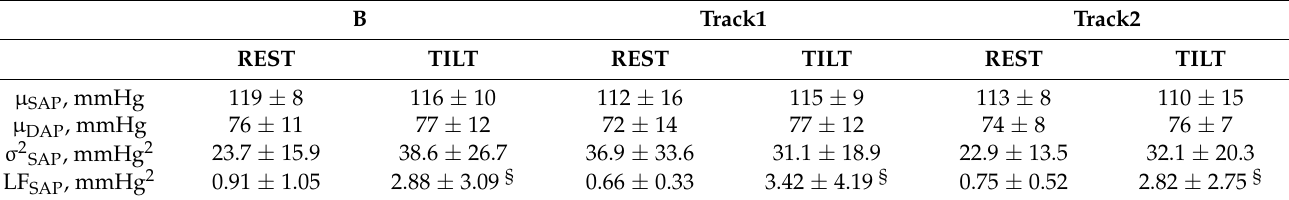
Table 3. Results of the arterial pressure variability analysis. B